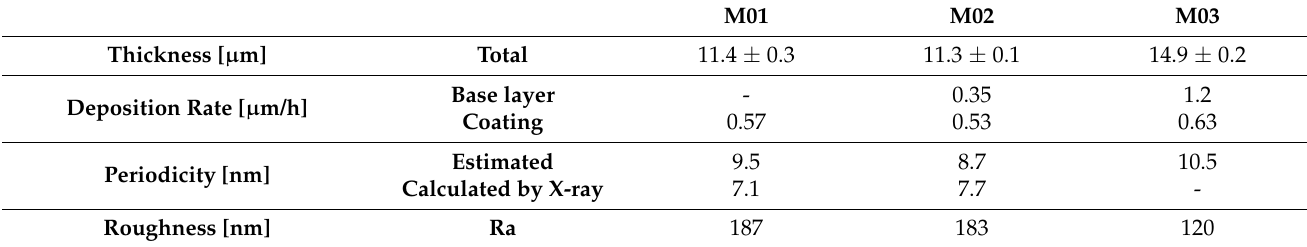
Table 2. The deposition rate and periodicity based on the thickness values measured with the SEM images and the roughness calculated from the AFM